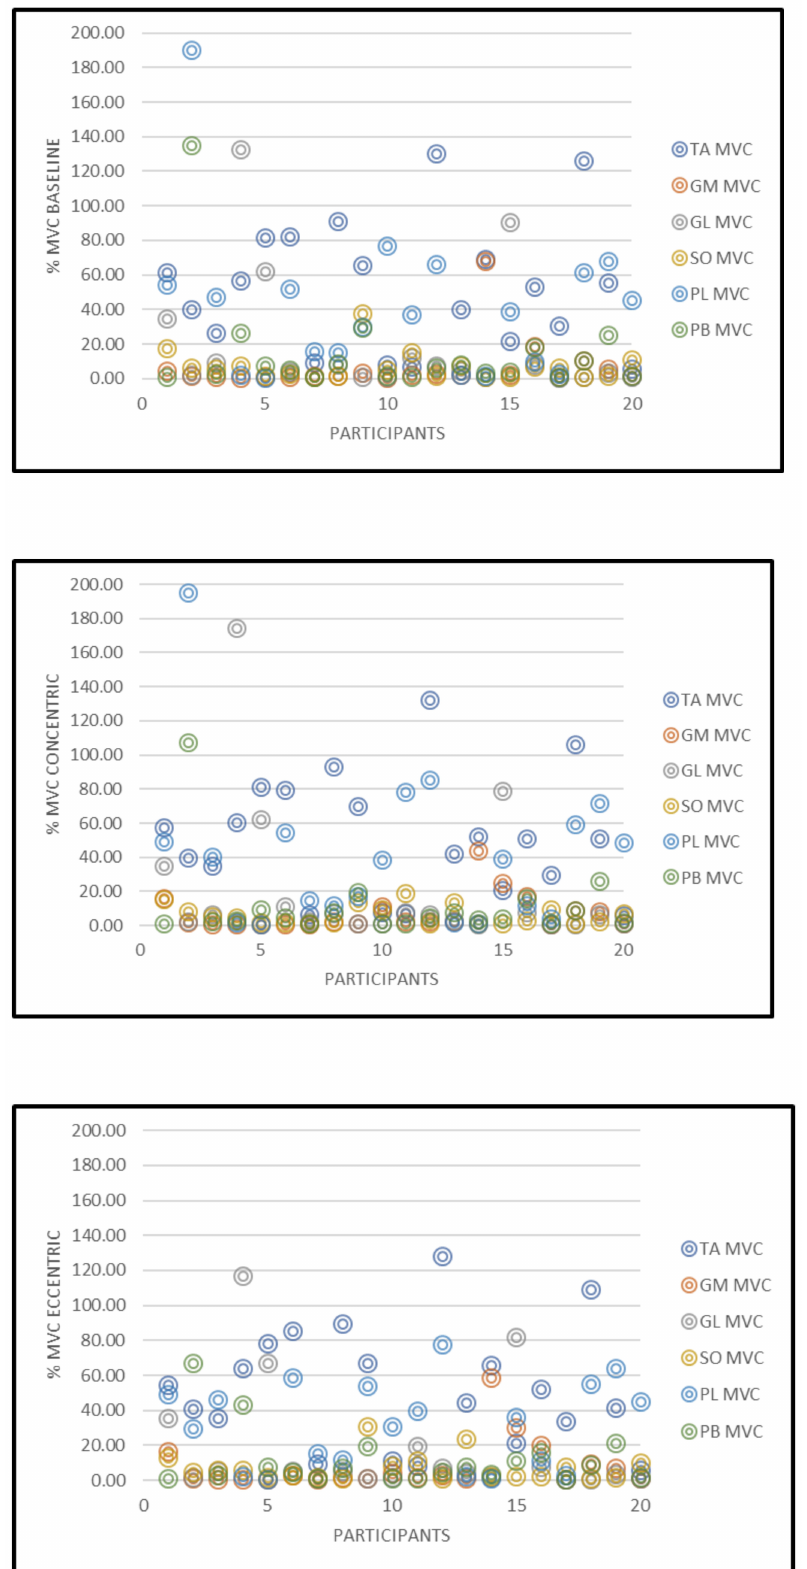
Figure 6. Representative data set showing the percentage maximum voluntary contractions scatter plots at baseline, concentric, and eccentric phases for all 20